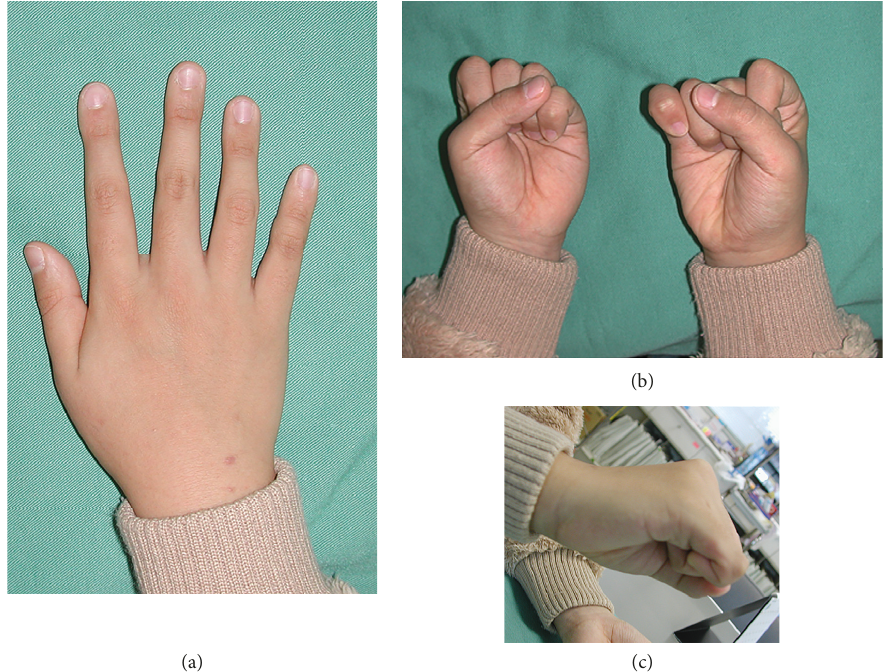
Figure 4: Photographs of Case 1 taken 1 year postoperatively. (a) Dorsal view. (b) Palmar view of the clenched fist. The alignment of the little finger was good. Because of the retained extension contracture of the metacarpophalangeal joint, the tip of the little finger could not touch the palm. (c) Lateral